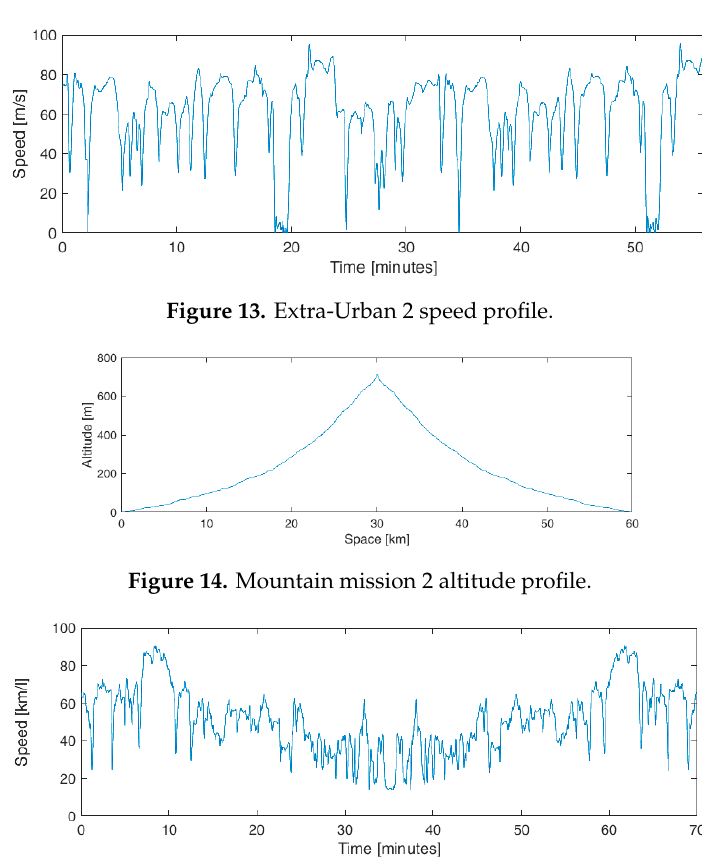
Figure 12. Extra-Urban 2 altitude profile.